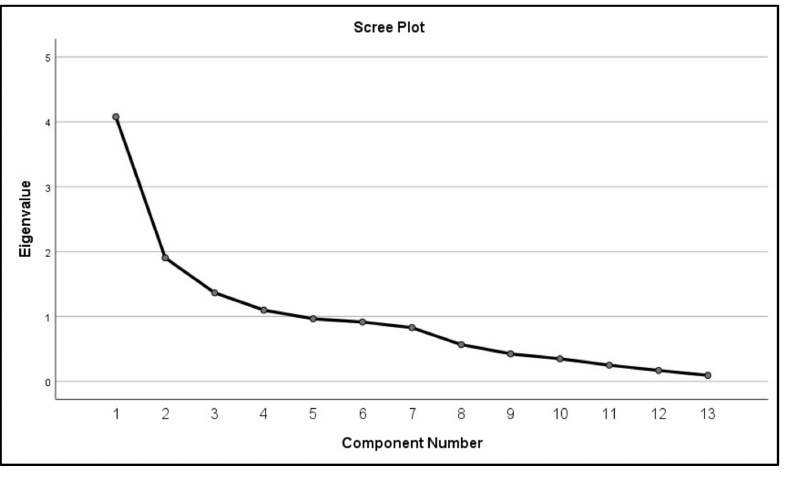
Figure 1. Scree plot showing the four principal components. To enhance the discrimination of components, orthogonal varimax rotation with Kaiser normalization was used. The instruction to suppress small coefficients of absolute value below 0.5 was selected, which made it easy to know which variables were loading under a particular component. In line with Kamadi et al. [76], a split was made between factor loadings with values higher than 0.5 and lower than 0.5 to develop the basis on which to classify dairy cattle farms and to select variables for the hierarchical cluster analysis. These PCs explain up to 65% of the total variation (Table 3). The first PC explains the largest percentage of variation (21%) after orthogonal rotation (varimax rotation), while the fourth PC explains only